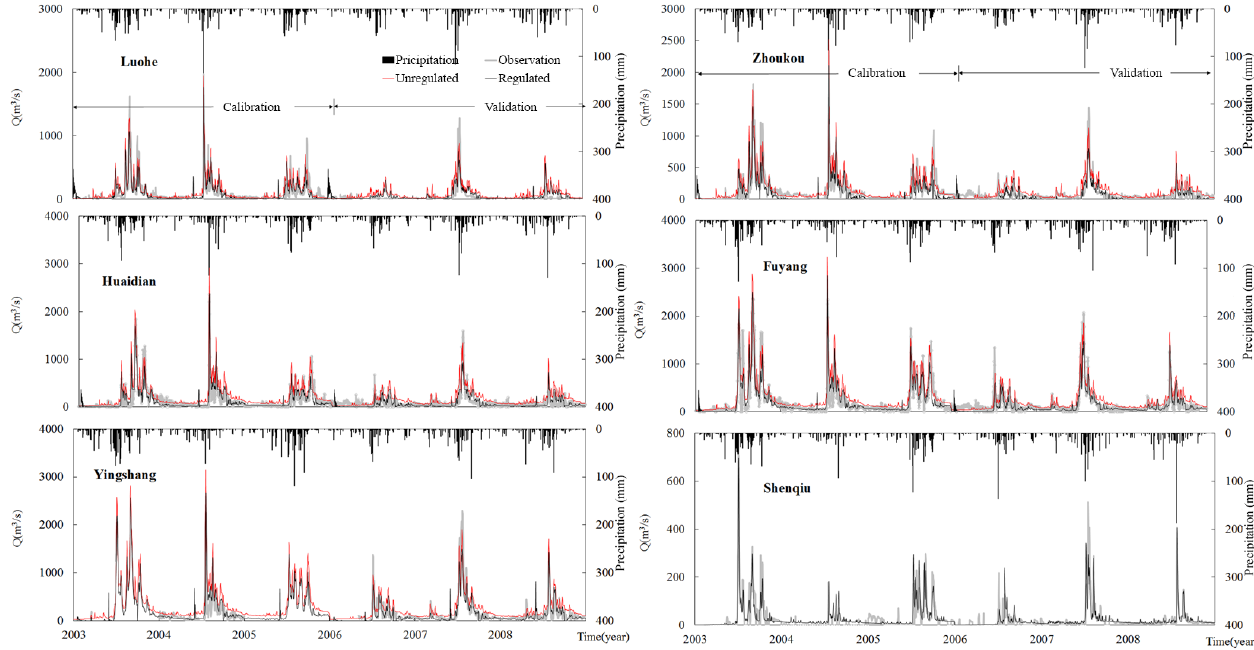
Figure 7. The daily runoff simulation at all stations. Table 3. Runoff simulation results for regulated and less-regulated stations.